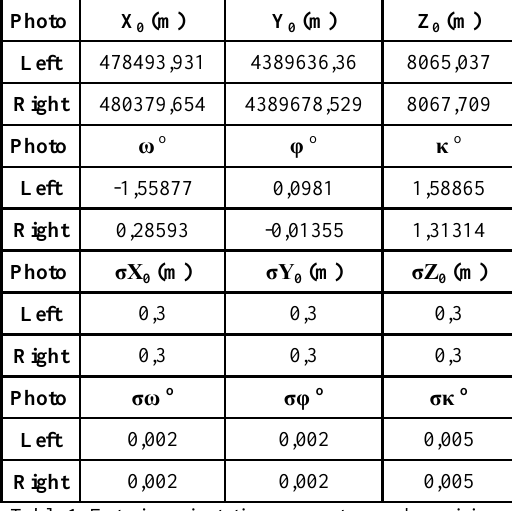
Table 1. Exterior orientation parameters and precisions PPA (x 0 , y 0 ) and focal length precision is included in calculation as 1 micron and zero with respectively. Totally 80 tie points’ image coordinates are measured in each stereo image. Distribution of points is shown at Figure 1.